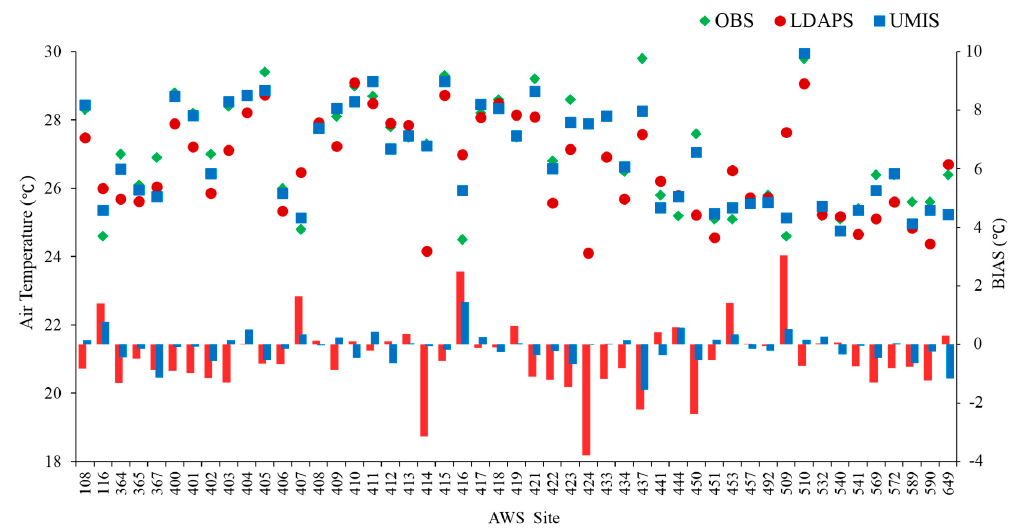
Figure 10. Validation of the temperature at the time of the daily minimum temperature for each automated weather station (AWS; forecast day: 04 August 2017 21:00 UTC). OBS, observed data; LDAPS, Local Data Assimilation and Prediction System; UMIS, Urban Meteorological Information System.